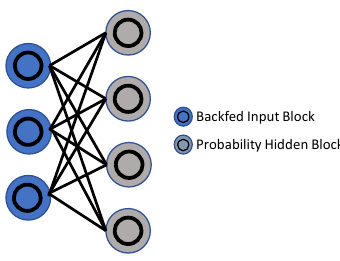
Figure 11. DBN block diagram.